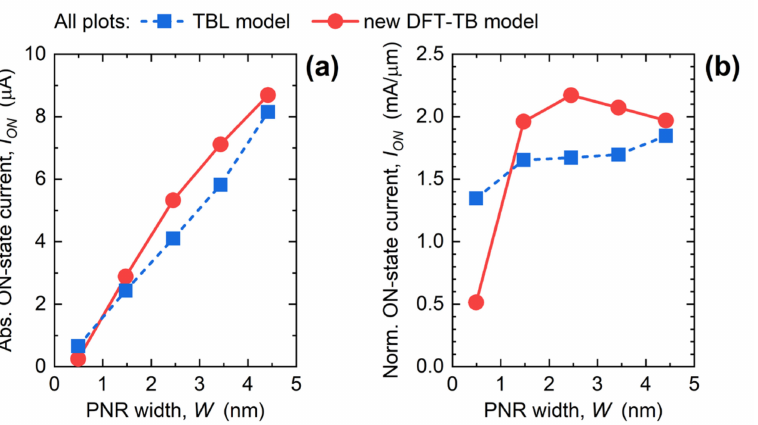
Figure 5. Impact of PNR width downscaling on ( a ) absolute I ON and ( b ) width-normalized I ON in PNR FETs. The plots compare the results obtained by DFT-TB and TBL